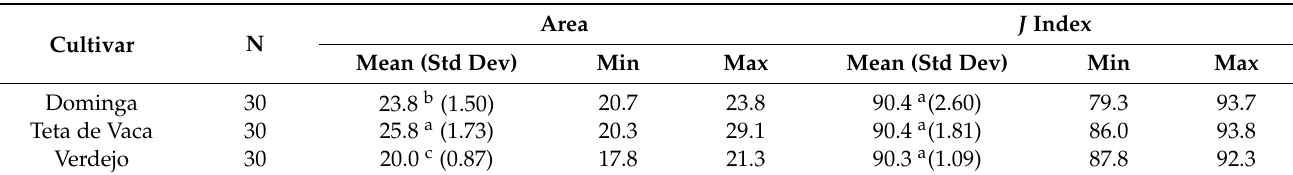
Figure 16. Teta de Vaca model. From left to right: A sum of the silhouettes of 30 seeds of cultivar Teta de Vaca, a silhouette obtained by the pixel profile of the first image, the Teta de Vaca model, and four representative seeds of this cultivar. Bar represents 1 cm. Table 9. Values of area and J index in the two cultivars of the Teta de Vaca group. Superscript letters indicate the results of Scheff é test: the mean values marked with the same letter in the superindex of each column do not differ significantly at p < 0.05. N is the number of seeds analyzed.